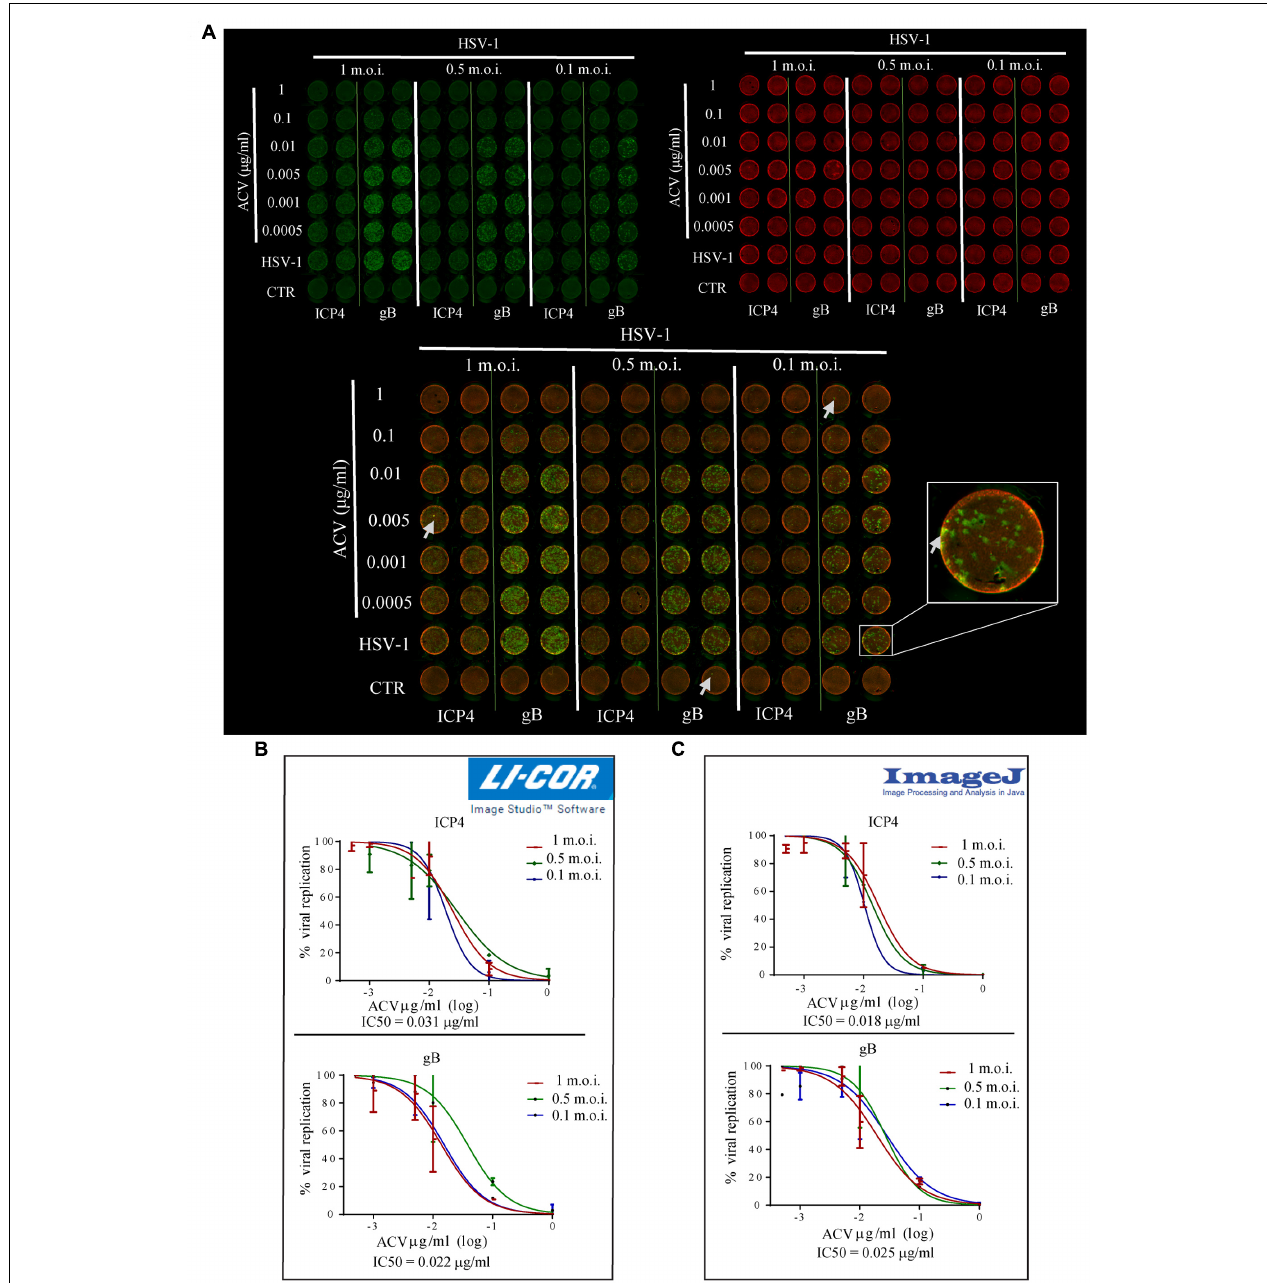
FIGURE 3 | “In-Cell Western TM ” Assay is a suitable technique for antiviral screening. (A) HSV-1 infected Vero cells (with the indicated m.o.i.) were treated for 24 h with concentrations of ACV ranging from 0.0005 to 1 µ g/ml. Fixed cells were incubated with anti-gB or anti-ICP4 antibodies and then stained with IRDye 800 CW (green fluorescence) and CellTag 700 Stain (red fluorescence). Arrows highlight unspecific fluorescence peaks (a close up view in the inset). (B,C) Representative dose-response curves of ACV activity on HSV-1 replication (shown as percentage of virus replication in ACV treated cells vs. untreated ones) using LI-COR Image Studio Software (B) or Image-J (C) for data analysis. ACV IC50 was calculated from each staining and the mean values resulted from experiments performed with different m.o.i. of virus are reported (0.031 µ g/ml for ICP4 staining, 0.022 µ g/ml for gB staining using LI-COR Image Studio Software; 0.018 µ g/ml for ICP4 staining, 0.025 µ g/ml for gB staining using Image-J